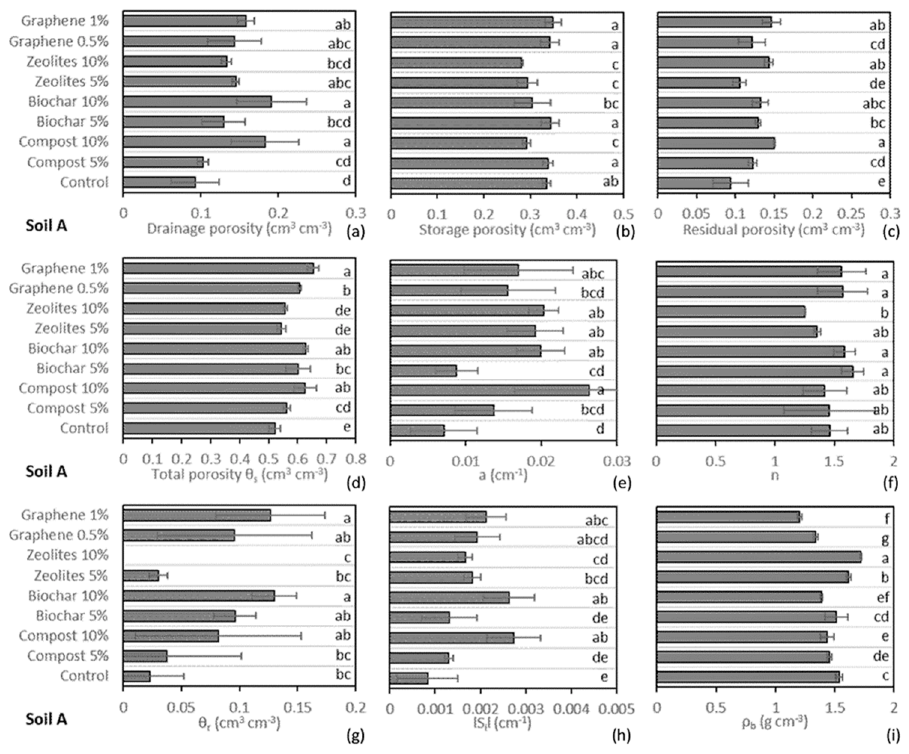
Figure 5. Mean ± st. dev. of drainage ( a ), storage ( b ), residual ( c ), and total (measured θ s ) porosities ( d ), fitted van Genuchten parameters ( e – h ), and ρ b ( i ) with the statistical LSD comparison between treatments for each parameter of Soil A. The same letter indicates no statistical differences among treatments.